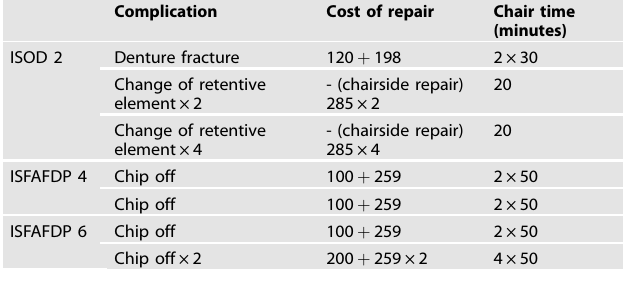
Table 2. Post-treatment events and costs: number of appointments, treatment time (minutes) and costs (Euro) for dental technical laboratory work.